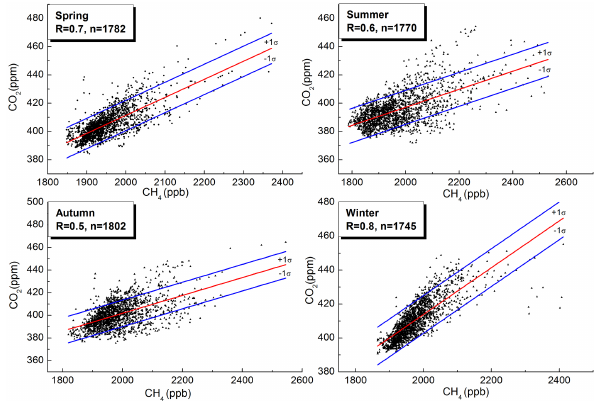
Figure 3. Correlations between CH 4 and CO 2 mole fractions based on all data from 10:00 to 16:00LT at LAN station. Spring: March– May; summer: June–August; autumn: September–November; win- ter: December–following February. The red lines show linear fits between the CH 4 and CO 2 mole fractions. The blue lines in each chart bracket the CO 2 values within ± 1 σ of the data from 10:00 to 16:00LT in each